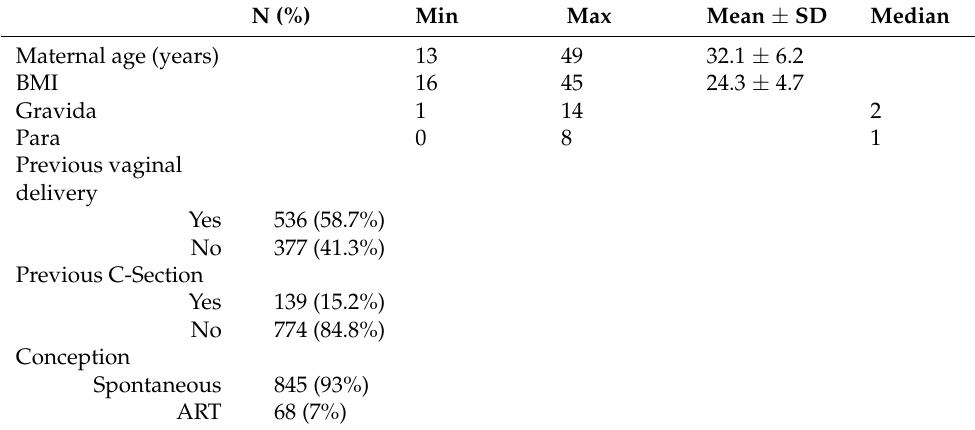
Table 1. Maternal characteristics.